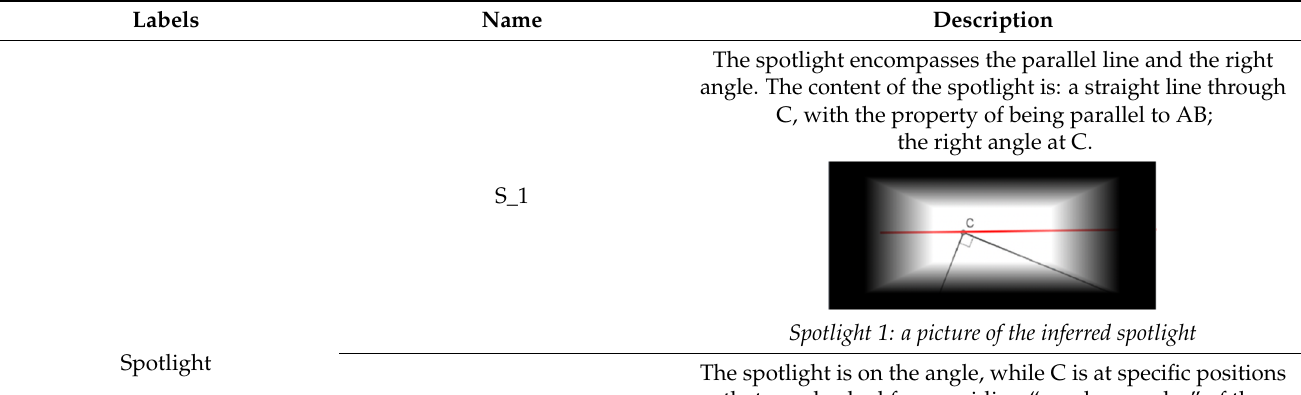
Table 2. Main elements from the analysis of Excerpt 1.